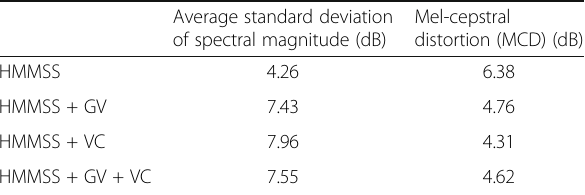
Table 1 Objective evaluation results